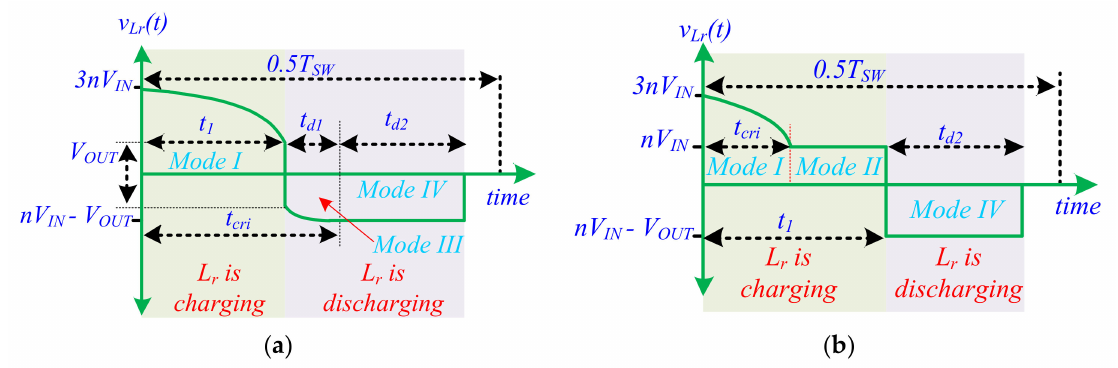
Figure 7. Timing diagram of the voltage across L r in the positive half-cycle in the boost - SRC conditions for ( a ) scenario B and ( b ) scenario